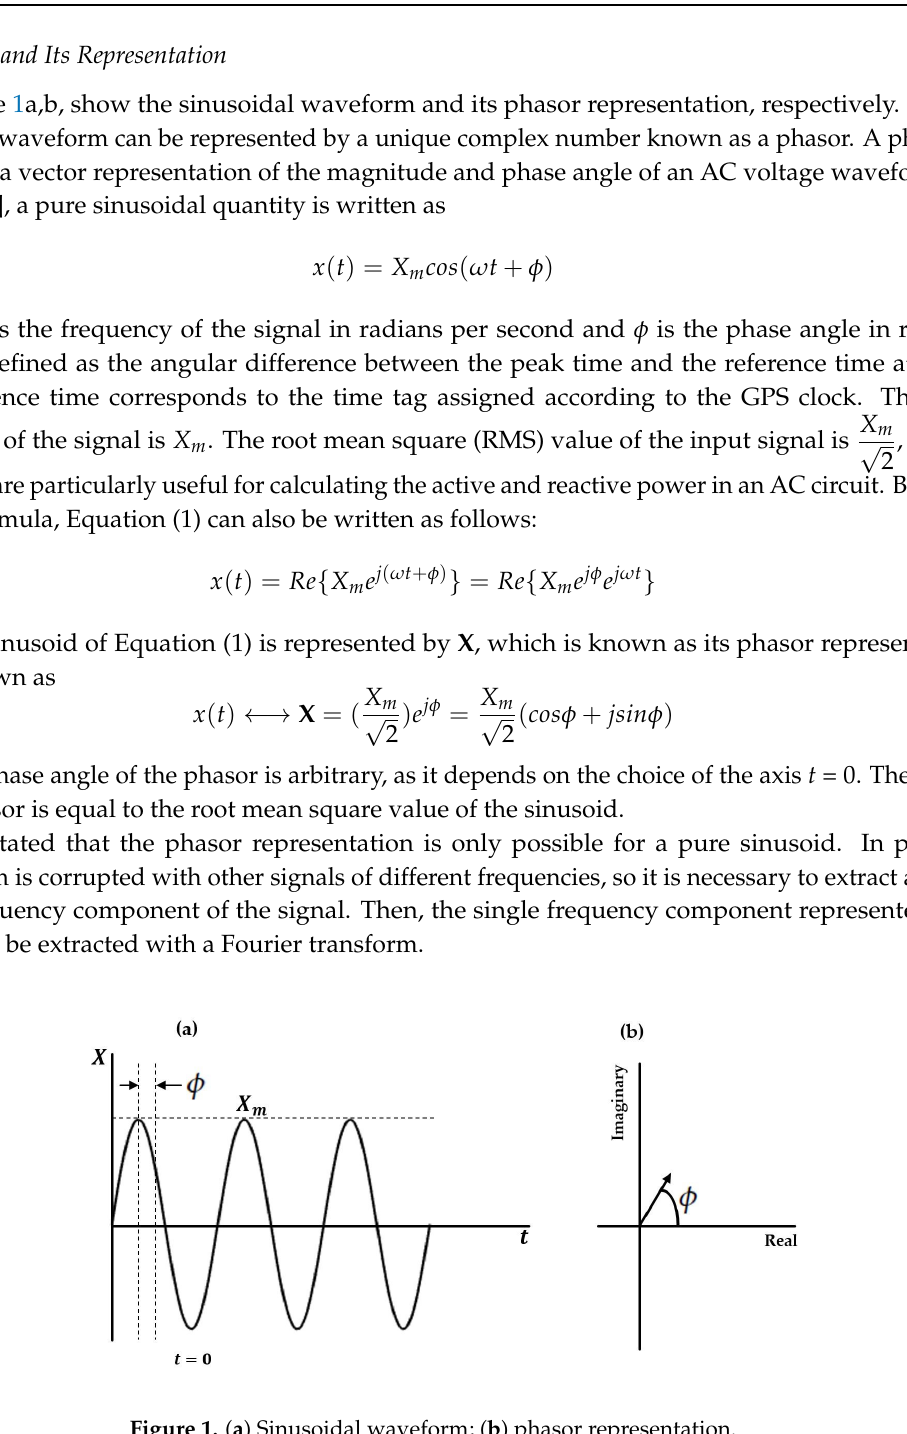
Figure 1. ( a ) Sinusoidal waveform; ( b ) phasor